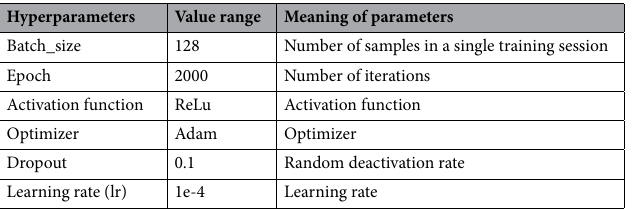
Table 1. The DeepDGC model hyperparameter settings.